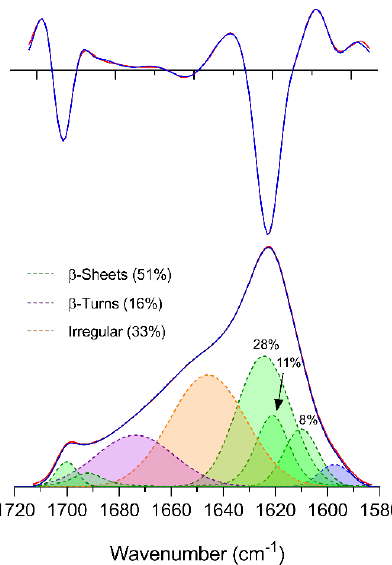
Figure 6. Band fitting of the amide I and its second derivative of regenerated SFNP. Top: second derivative of absorbance; bottom: ATR absorbance spectrum. Blue: Experimental spectrum and experimental second derivative; Red: fitted spectrum and fitted second derivative. The maximum ATR absorbance was 0.248 at 1622 cm −1 .